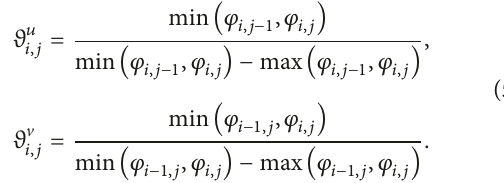
Figure 7: The time dependency for the torque 𝑀 flow = 𝑀 𝑧 (𝑡) (on the coarse grid 272 × 292 with time step Δ𝑡 = 0.0001 ) and filtered flow = 𝑀 (𝑡) for the time dependency 𝑀 𝑧